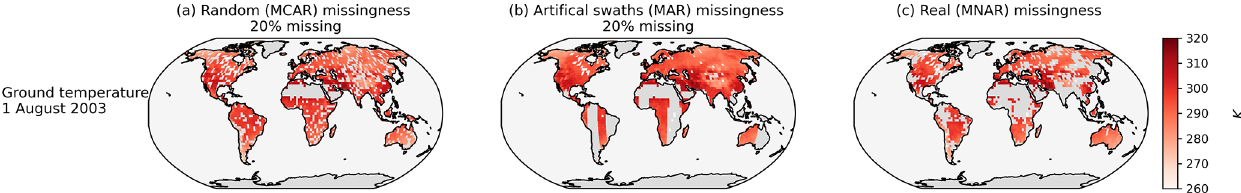
Figure 8. Comparison of artificial (a) random and (b) swath-only missingness and (c) missingness in the real data in an example snapshot of ERA-5 ground temperature from 1 August 2003. Random missingness was created by randomly sampling without replacement from the pool of all grid points on land at all time steps in the desired fraction of missing values. In the swath-only missingness data we create long ellipses centred around the Equator to simulate characteristic satellite swath missingness patterns. Note that the two missingness patterns are not exactly the same for each day and variable to allow for cross-variable learning.